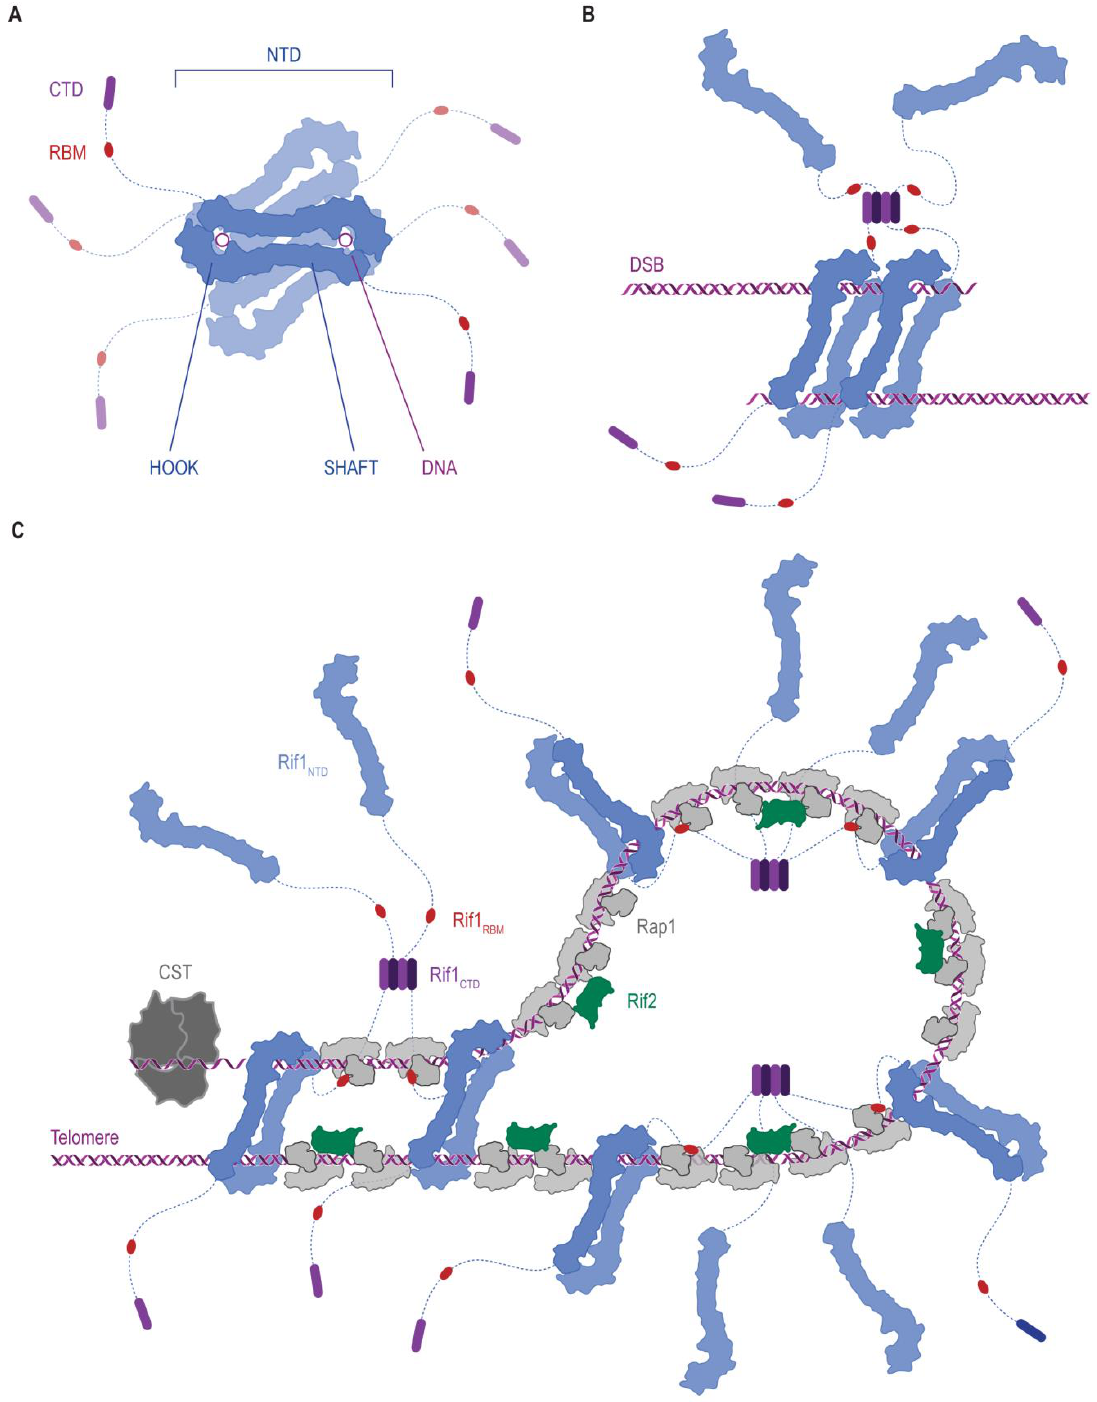
FIGURE 7: Ways in which Rif1 dimerization may promote DSB repair and shape telomere architecture. (A) Crystallographic model showing budding yeast Rif1 dimers bound to two DNA molecules [19]. The shepherd’s crook-like Rif1 NTD ( blue ) comprises an N-terminal HOOK and a straight SHAFT region. Rif1 RBM (Rap1-binding domain, red ) and Rif1 CTD (C-terminal tetramerization domain, purple ) are connected to Rif1 NTD by unstructured linker regions ( dotted lines ). Rif1 NTD has intrinsic DNA-binding activity and assembles on DNA as a figure 8-shaped, head-to- tail dimer. Multiple dimers may be organized around the same DNA molecules, forming a protein sheath, and restricting access of other proteins. (B) Speculative model of Rif1 dimers binding to the two ends of a DSB: tethering DSB ends in this way may promote re-ligation along the NHEJ pathway by keeping DSB ends in close proximity. (C) Schematic representation of the Velcro-like protein network formed by Rap1, Rif1 and Rif2 at yeast telomeres, taking DNA binding by Rif1 into account. Rap1 molecules ( grey ) directly bind dsDNA TG 1-3 tracts, recruiting Rif1 and Rif2. Rif2 ( green ) interlinks adjacent Rap1 molecules, while Rif1, forming tetramers via its CTD, engages multiple Rap1 molecules through RBM epitopes. The NTD may allow Rif1 to directly engage telomeric DNA at sites not covered by Rap1. Fold-back struc- tures could potentially be stabilized by Rif1-mediated OPEN ACCESS | www.microbialcell.com 336 Microbial Cell | JULY 2018 | Vol. 5 No. 7